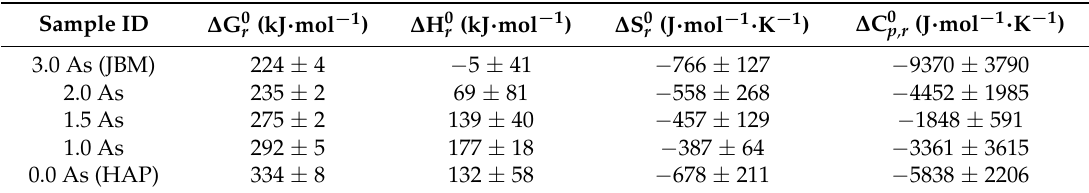
Table 6. Experimentally determined thermodynamic functions of the dissolution reaction in JBM–HAP solid solution series at temperature T of 298.15 K and pressure p of 0.1 MPa.